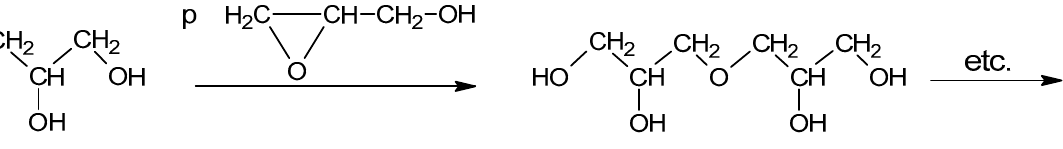
Figure 2. IR spectra of polyols (CS + H 2 O + GL) + EC (red), (CS + GLYC + GL) + EC (blue), (CS + GL) + EC (green), and (CS + GL + EC) (black).